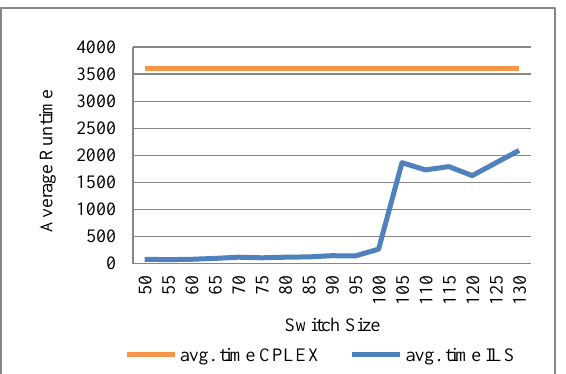
Figure 4. Average runtime of the ILS algorithm on the instances of the same size compared to CPLEX.